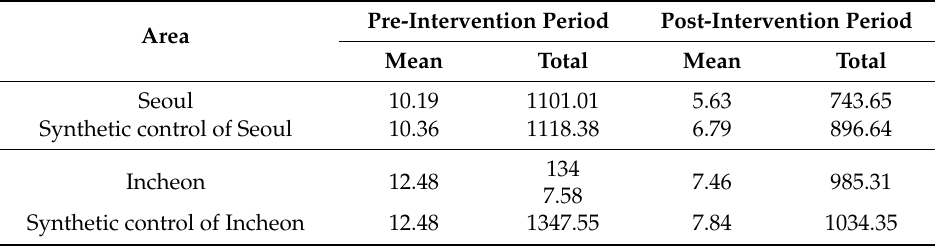
Table 1. Monthly age-standardized cardiovascular mortality rate (per 100,000) in Seoul, Incheon and synthetic controls.